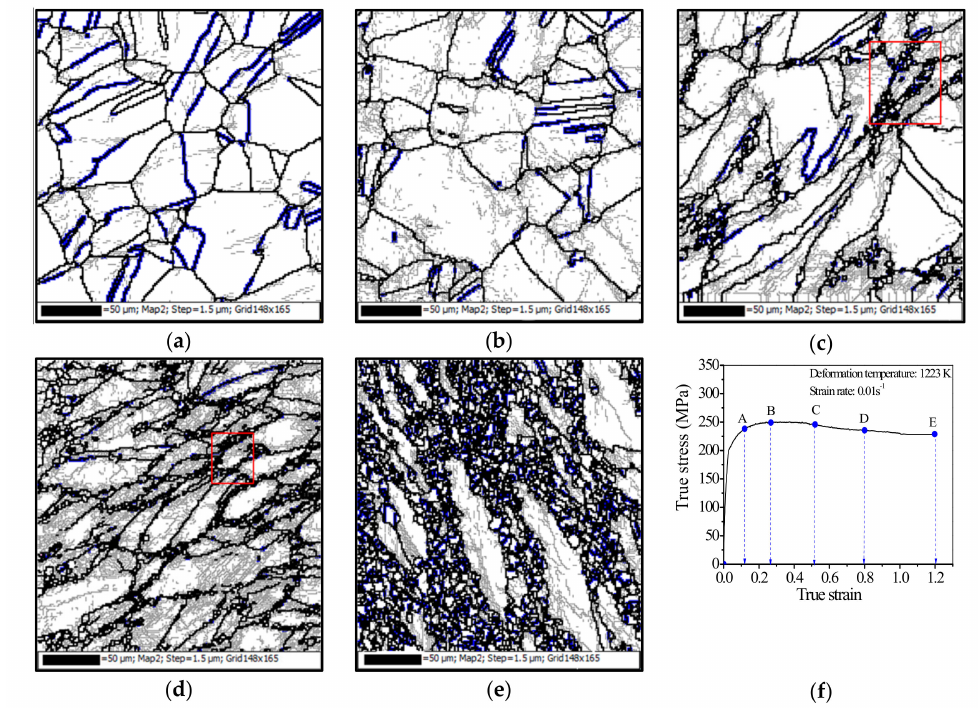
Figure 4. Orientation imaging microscopy maps at the strains of: ( a ) 0.12; ( b ) 0.27; ( c ) 0.52; ( d ) 0.8; ( e ) 1.2; ( f ) true stress-true strain curve (LAGBs, HAGBs and annealing twin boundaries are indicated by thin-gray, thick-black, and thick- blue lines,